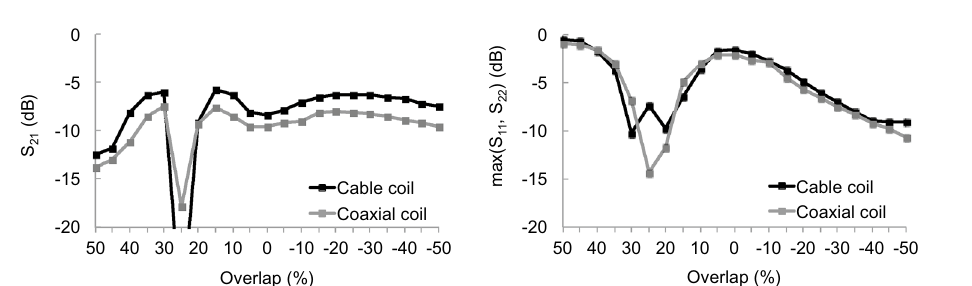
Figure 4. SNR profiles as a function of depth in a phantom for cable and coaxial coils arranged with circular (left), 13 × 8-cm elliptical (middle), and 15 × 6-cm elliptical geometry (right). Scaled representations of the coil contours are overlaid.